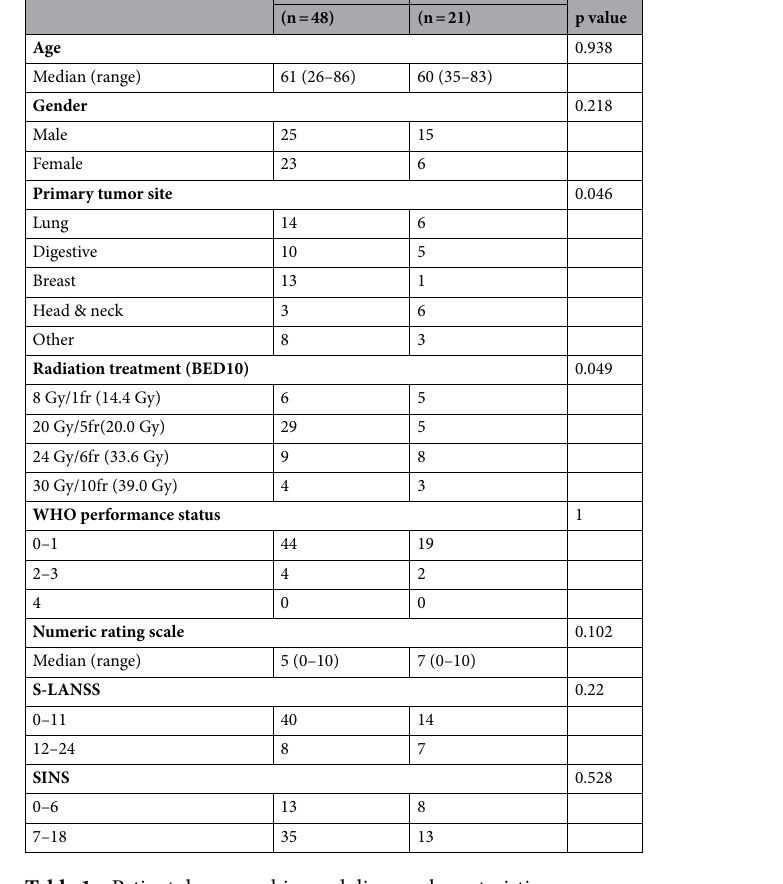
Table 1. Patient demographics and disease